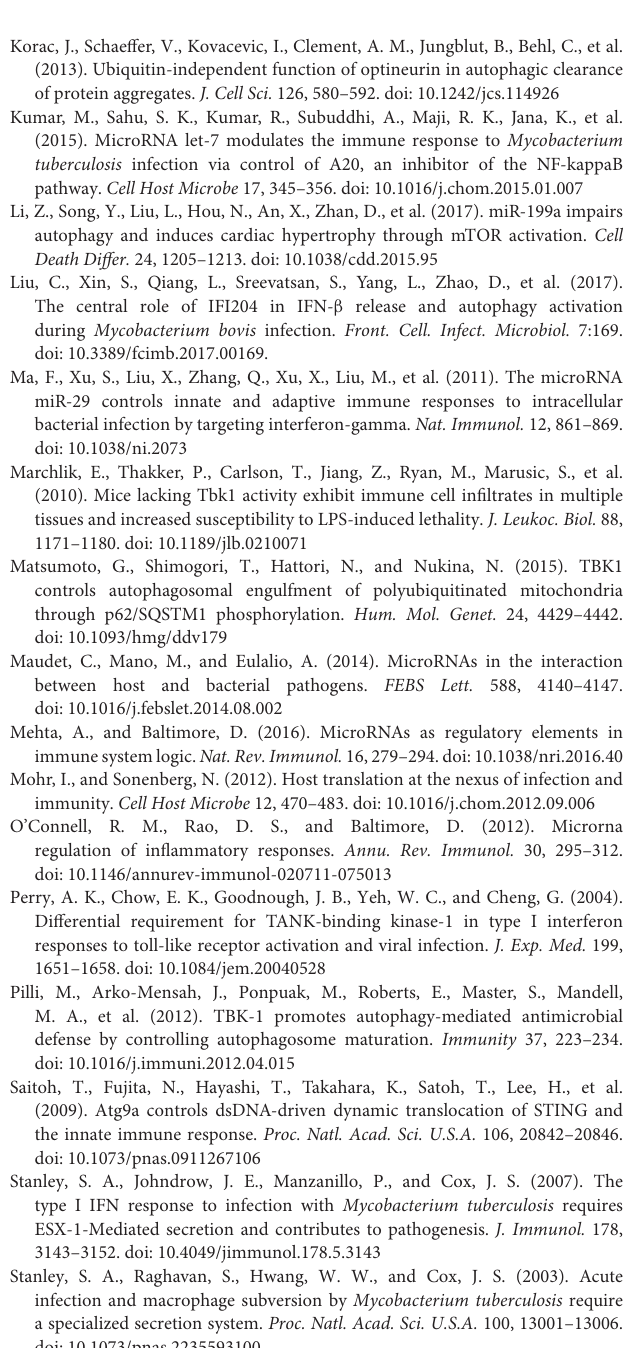
Supplementary Figure S1 | The sequence of miR-199a and miR-199b similar target TBK1 at 3 ′ UTR from target scan.